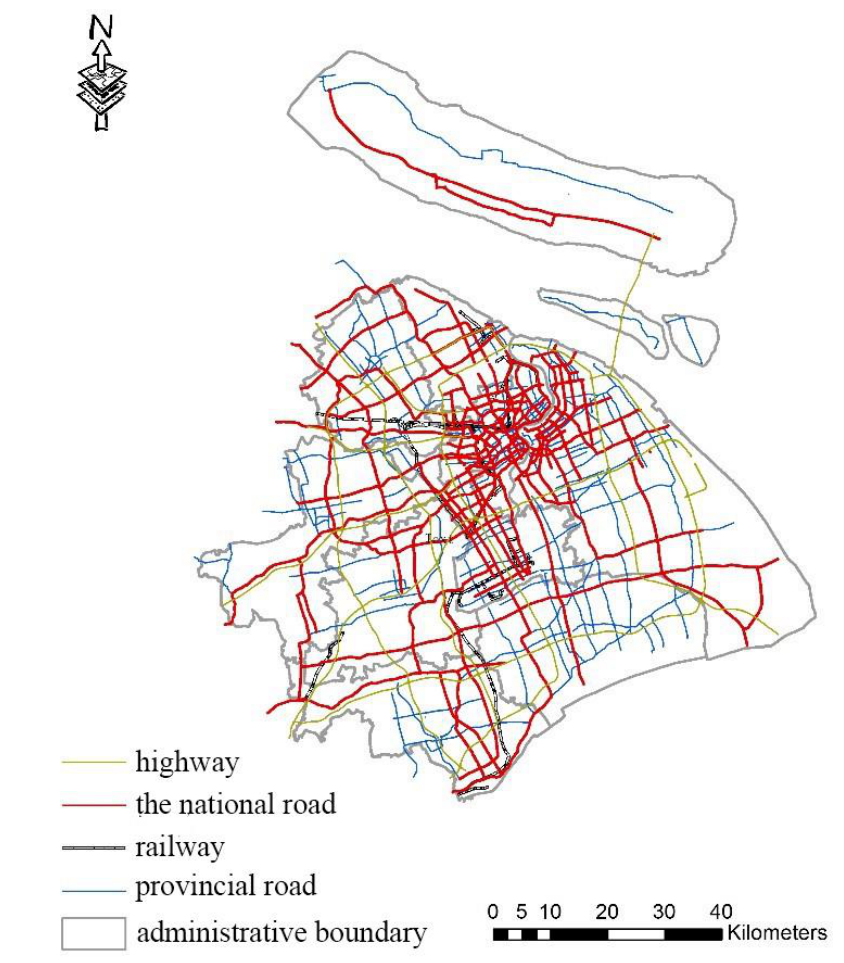
Figure 3. Spatial distribution of transportation routes in